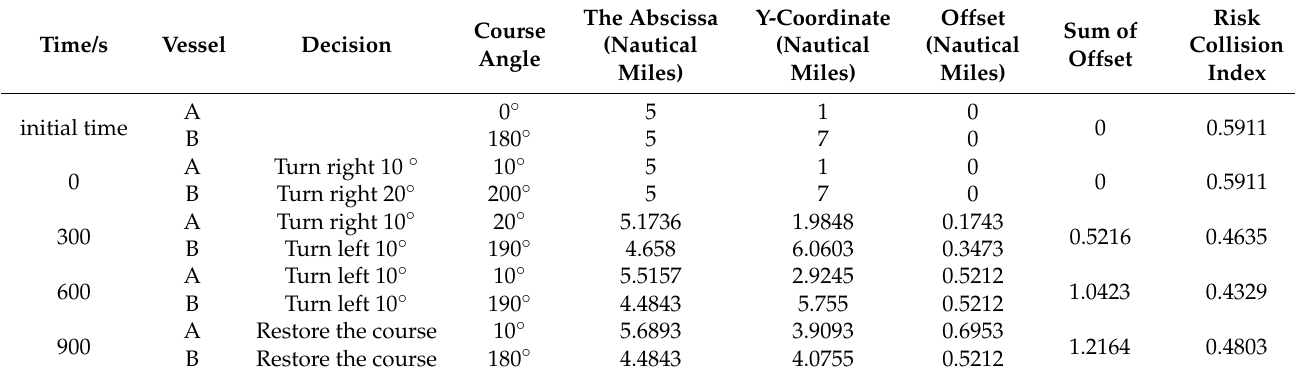
Table 2. Simulation results of encounter